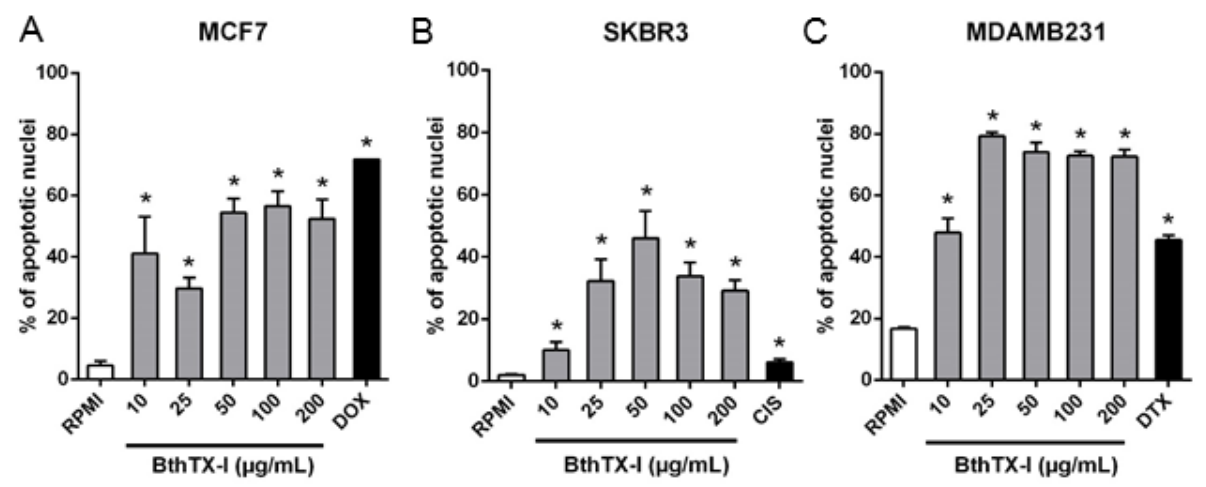
Figure 3. Percentages of hypodiploid nuclei in ( A ) MCF7, ( B ) SKBR3, and ( C ) MDAMB231 breast cancer cell lines treated with BthTX-I for 12h, through quantification of apoptotic nuclei by the hypotonic fluorescent solution method. Cells treated with ( A ) DOX (4 µM doxorubicin), ( B ) CIS (100 µM cisplatin), or ( C ) DTX (20 µM N-desmethyltamoxifen) were used as positive control. RPMI: cells incubated in estrogen-free RPMI 1640 medium supplemented with CS-FBS (negative control). Values represent mean ± SD of at least three independent experiments. * p < 0.05 vs. negative control (ANOVA combined with the Tukey post-hoc test). ns: no significant difference between results in bracket (p > 0.05).